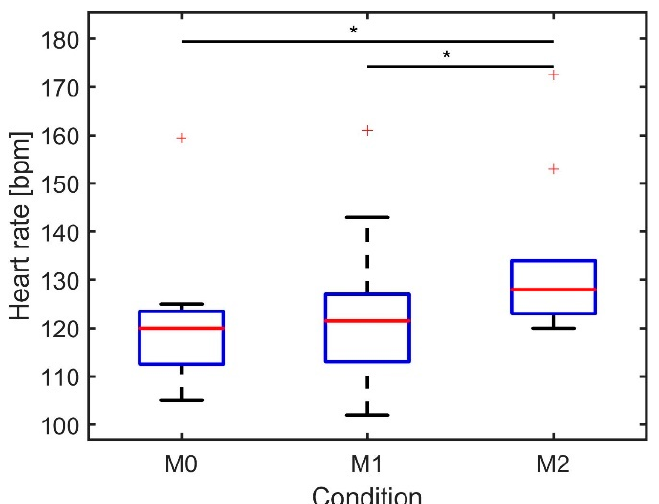
Figure 6. Boxplot of the median heart rate during agility run + 2 min rest afterwards over three repetitions per condition ( n = 10). The asterisk indicates a significant difference between the conditions: * p < 0.01.